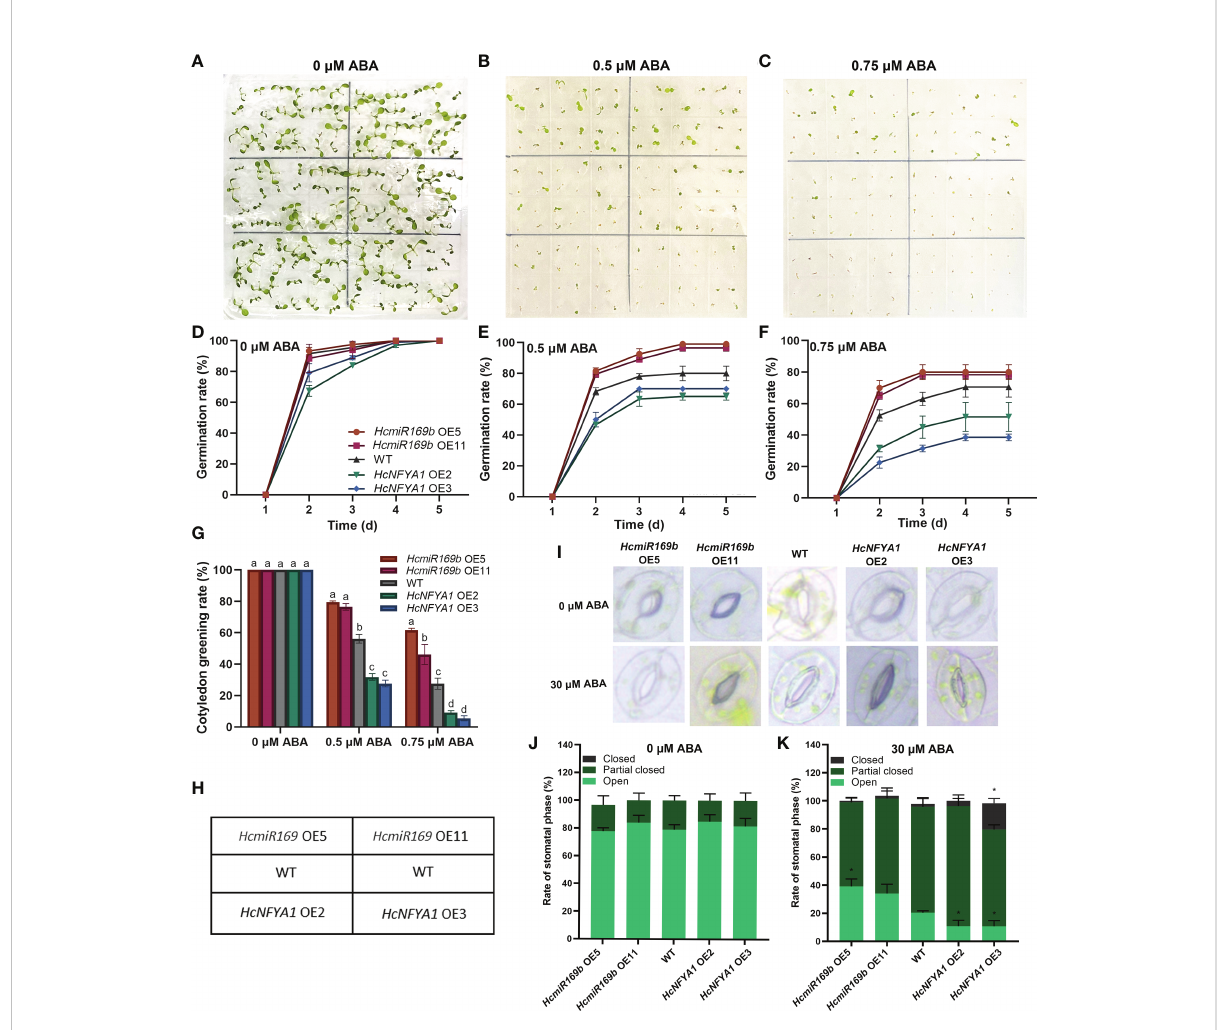
FIGURE 7 Halostachys caspica miR169b/NFYA1 module responds to the exogenous hormone ABA. (A-G) Seed germination phenotypes (A – C) , germination curves (D-F) , and cotyledon greening rate (G) of Arabidopsis under 0 m M, 0.5 m M, and 0.75 m M ABA treatments. (H) Layout designs of fi gure A-C. (I-K) Stomatal aperture photographs (I) and percentage of various stomata (J, K) of Arabidopsis leaves under 0 m M ABA and 30 m M ABA treatments. Data were shown as the means ± SD of three biological replicates. Different letters indicated signi fi cant differences in cotyledon greening rate of each type of Arabidopsis between treatments (Duncan ’ s multiple range test, p <0.05), asterisk indicated a signi fi cant difference in the percentage of this stomatal type compared with WT (Student ’ s t-test, * p